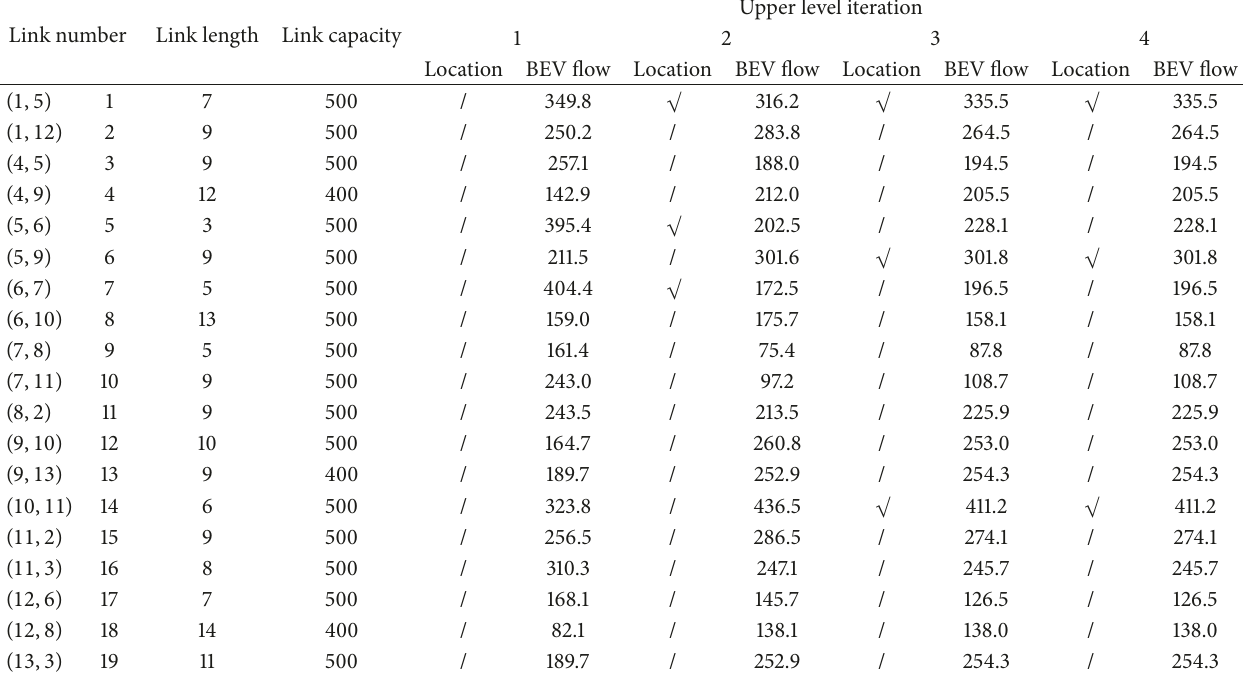
Table 3: The charging facility locations and BEV flows over iterations.